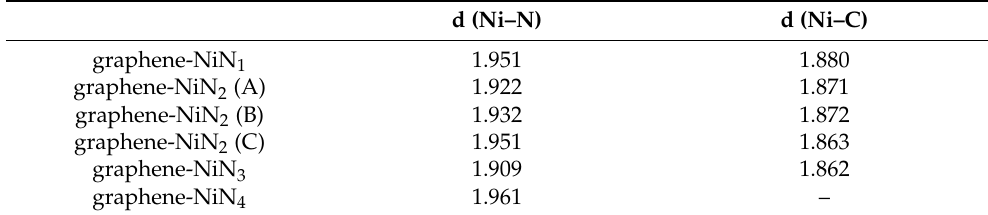
Figure 1. Optimized structures of C 2 H 2 , H 2 , graphene-NiN 1 ( a ), graphene-NiN 2 (A) ( b ), graphene- NiN 2 (B) ( c ), graphene-NiN 2 (C) ( d ), graphene-NiN 3 ( e ), and graphene-NiN 4 ( f ). Table 1. Average bond lengths of Ni–N and Ni–C for graphene-NiN x catalysts (x = 1, 2, 3, 4) (unit: Å).